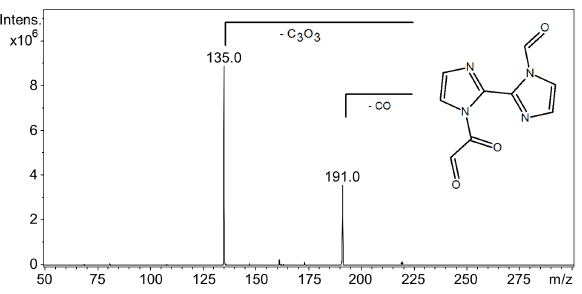
Figure 6. MS/MS of a compound with m/z 219 eluting at 10.6 min retention time. Tentative structure 2 Fig. 6. MS/MS of a compound with m/z 219 eluting at 10.6min and neutral losses are shown. 3 retention time. Tentative structure and neutral losses are